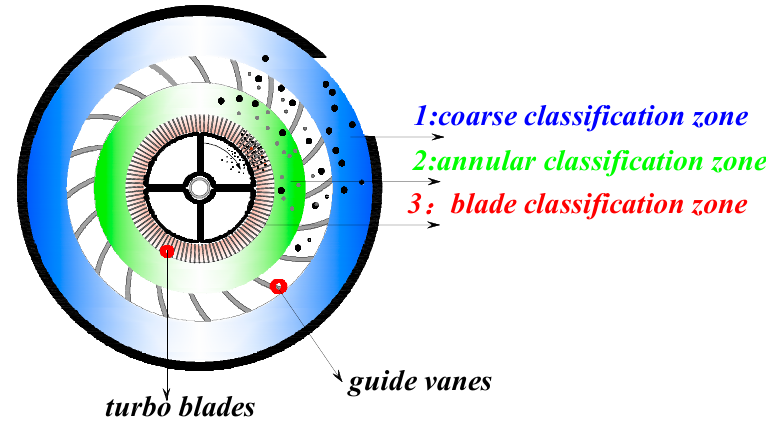
Figure 1. Schematic diagram of grading functional area of turbo air classifier.